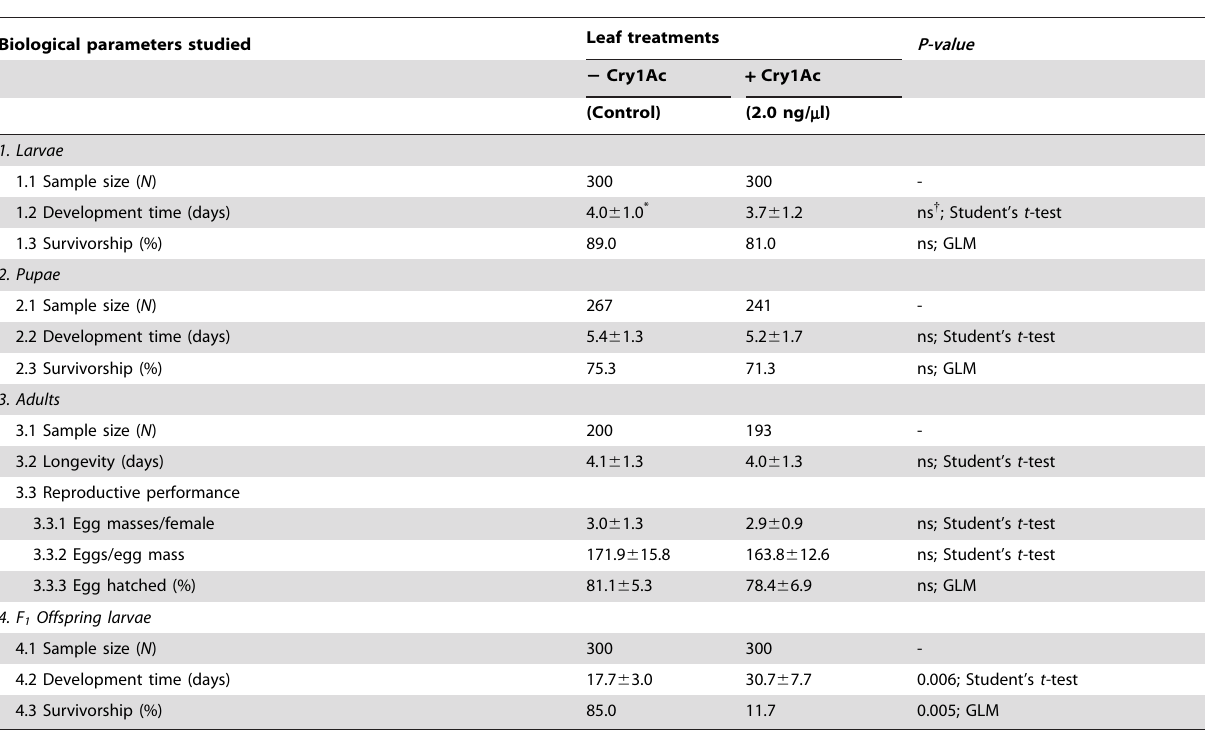
Table 3. Leaf dip bioassay with Cry1Ac on 3 rd instar larvae of Chlosyne lacinia , and surviving pupae and adults and their offspring.